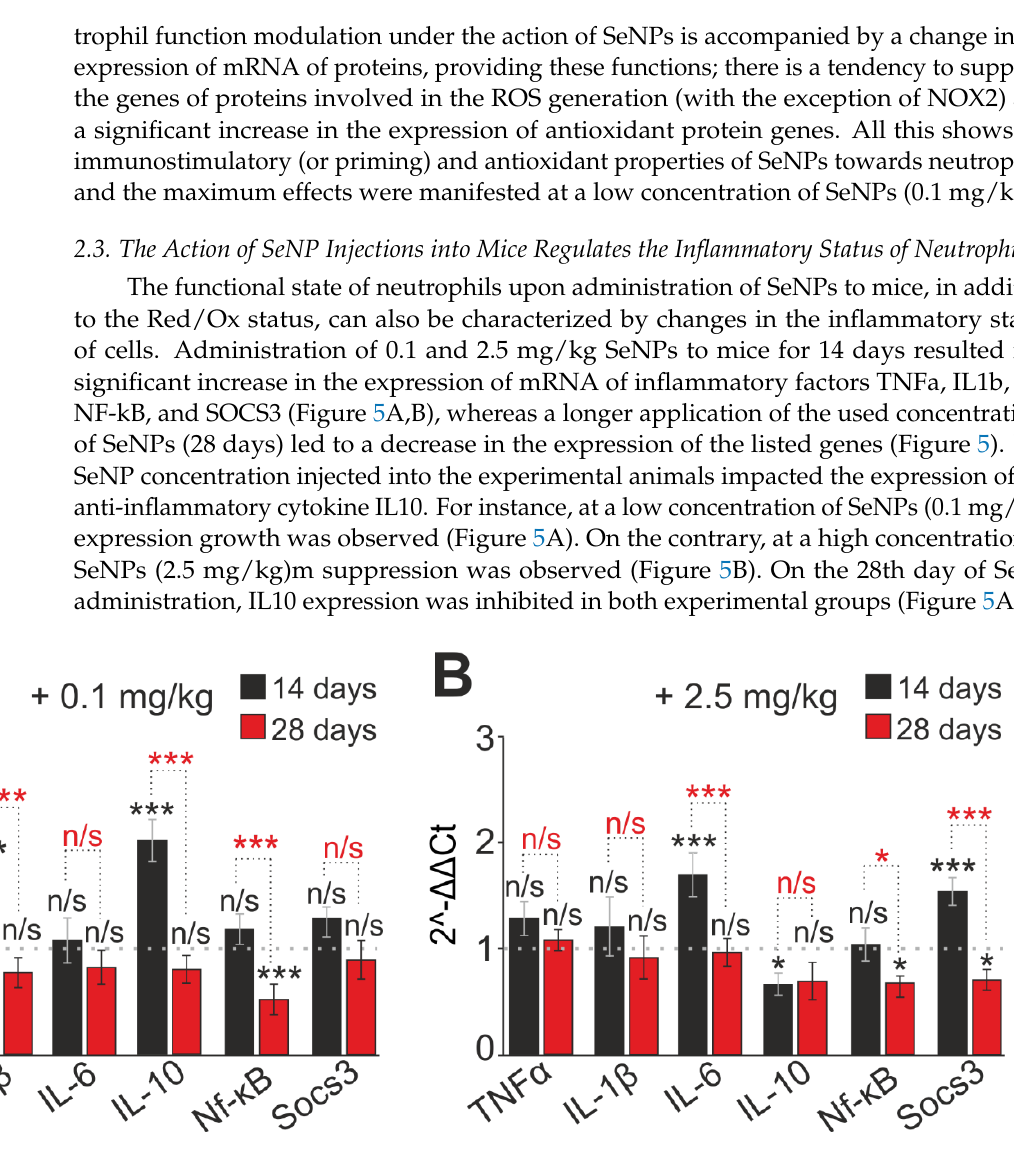
Figure 5. The introduction of 0.1 ( A ) and 2.5 ( B ) mg/kg SeNPs for 14 and 28 days impacted the expression of genes associated with inflammation. Neutrophils prepared from mice 14 (black bars) and 28 (red bars) days after 0.1 mg Se/kg ( A ) and 2.5 mg Se/kg ( B ) SeNPs were injected daily. GAPDH was used as housekeeping gene. Data were analyzed by 2 (- ΔΔCT ) method. Dashed line — level of gene expression in controls (mice with administration of saline). Data are expressed as mean ± SEM of five independent experiments. Statistical analysis of experimental groups versus control was performed with paired t -test and marked with black asterisks. Significance between experimental groups marked with red asterisks: *** p < 0.001 and * p < 0.05; n/s — no significance.